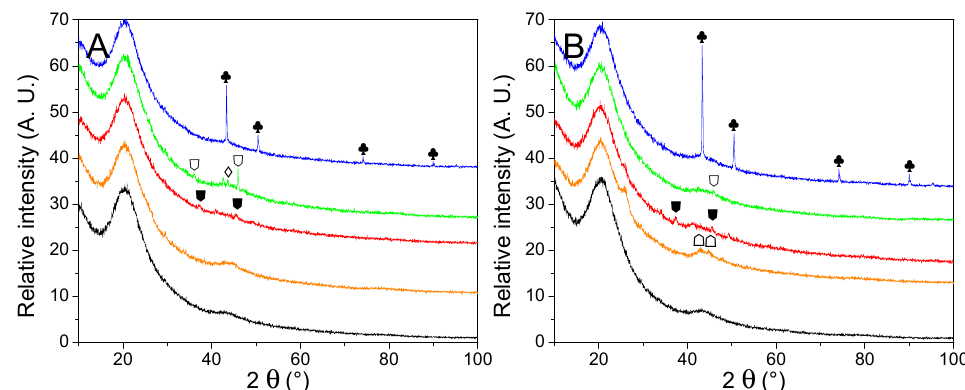
with LiBH 4 Table 3. Crystallographic parameters of the NPs obtained by PXRD of matrixes just impregnated loss ( • ). Fe 2 B is marked ( ☖ ). A possible graphite species is marked for G2N Fe and G2N Co (  ). Co ( ♥ ), Ni ( ♦ ), Cu ( ♣ ). Impregnated LiBH 4 is marked in GN50 and G2N50, assuming crystal order Fe (orange), Co (red), Ni (green) and Cu (blue) nanoparticles. Crystalline structures are marked for Figure 5. PXRD traces of just-impregnated GN50 ( A ) and G2N50 ( B ) matrixes (black) decorated with